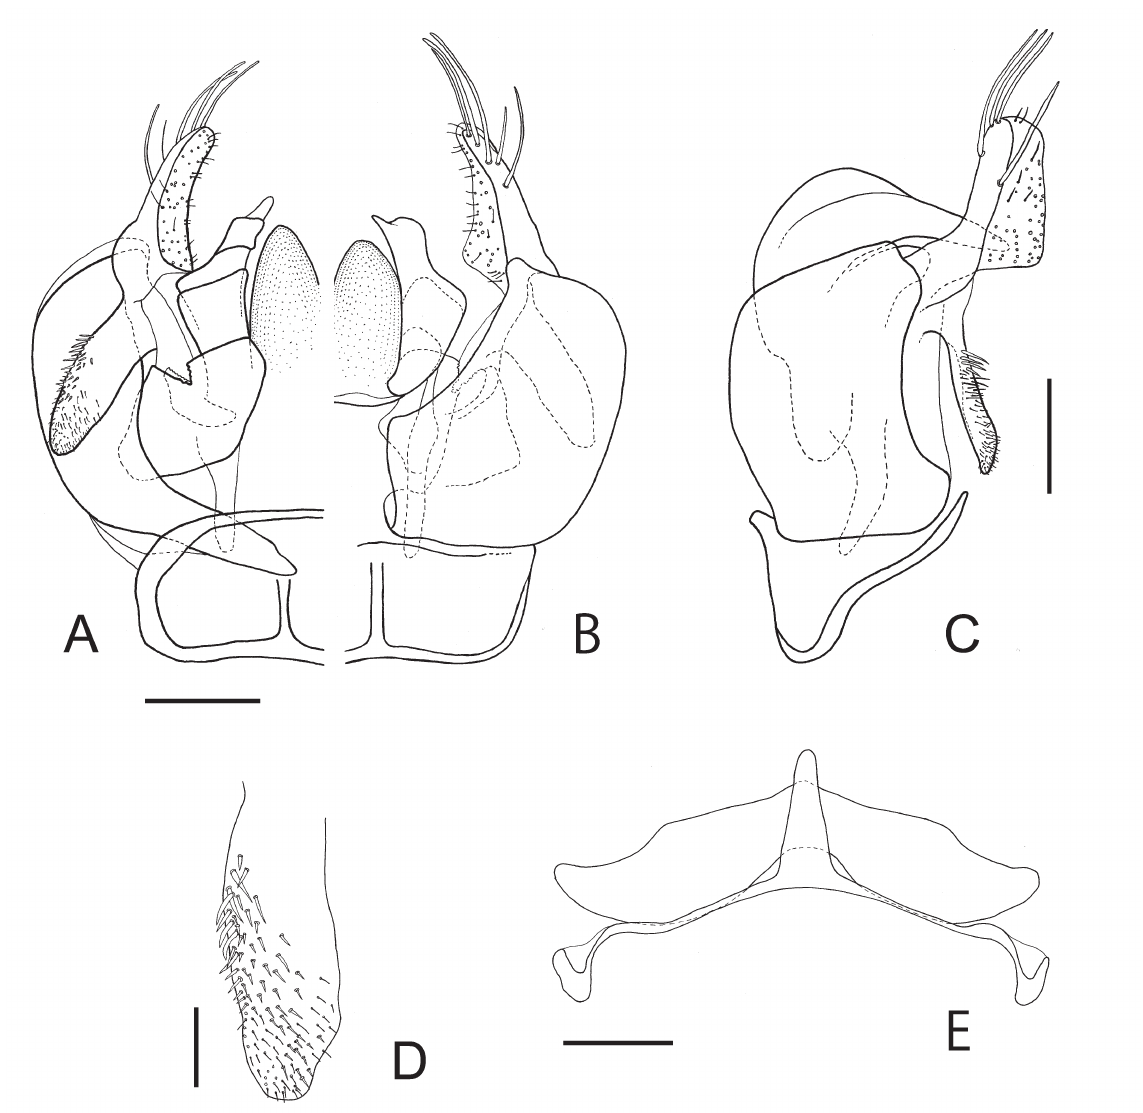
Fig. 9. Lasioglossum ( Dialictus ) virideglaucum Ebmer & Sakagami, 1994, ♂. A . Genitalia in ventral view. B . Genitalia in dorsal view. C . Genitalia in lateral view. D . Ventral retrorse lobe of genitalia. E . S7–S8. Scale bars: a–c, e = 0.2 mm, d = 0.1